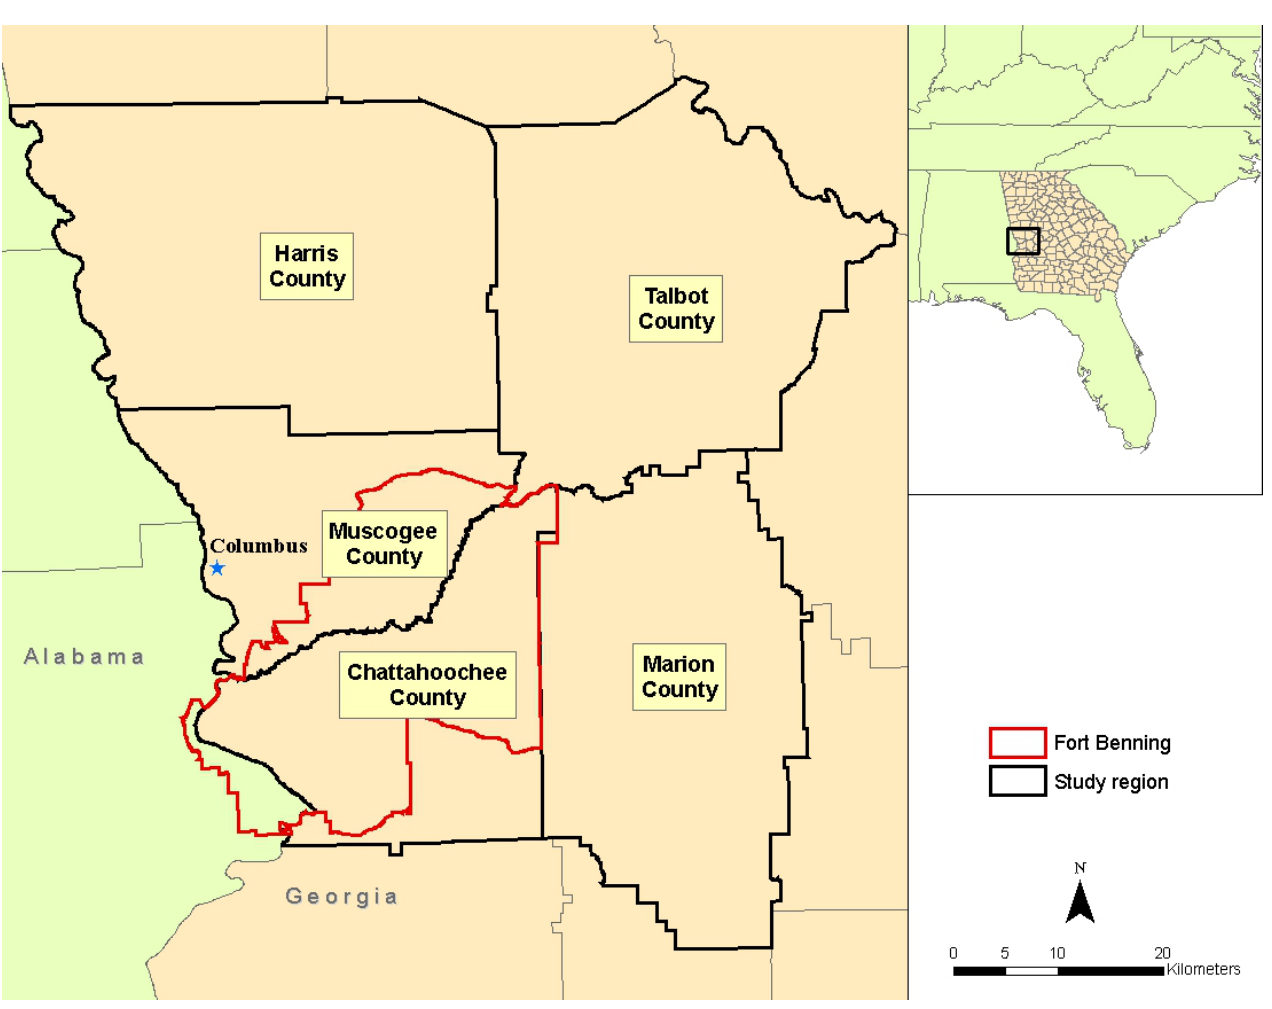
Fig. 1. Study region in west central Georgia,